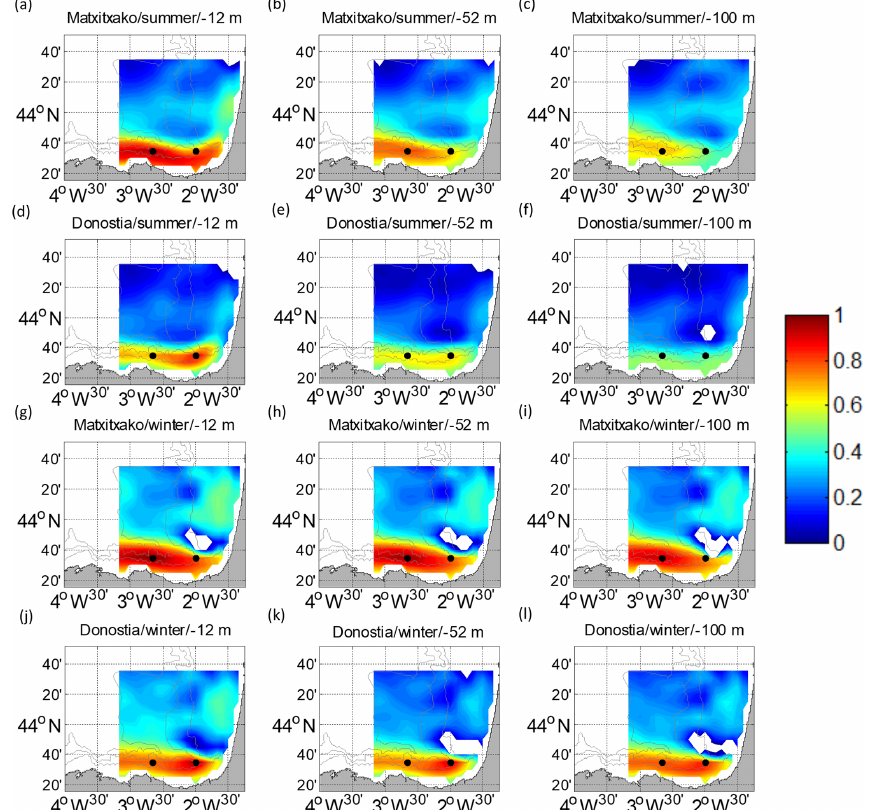
Figure 4. Temporal cross-correlation maps between the water column levels considered and the surface points of the HFR grid for U . (a, b, c, g, h, i) for the Matxitxako mooring and (d, e, f, j, k, l) for the Donostia mooring. Different depths are considered: − 12m (a, d, g, j) , − 52m (b, e, h, k) and − 100m (c, f, i, l) , for summer (a–f) and winter (g–l) . The white gaps are the areas where the confidence level is less than 95%. The black dots depict the locations of the current vertical